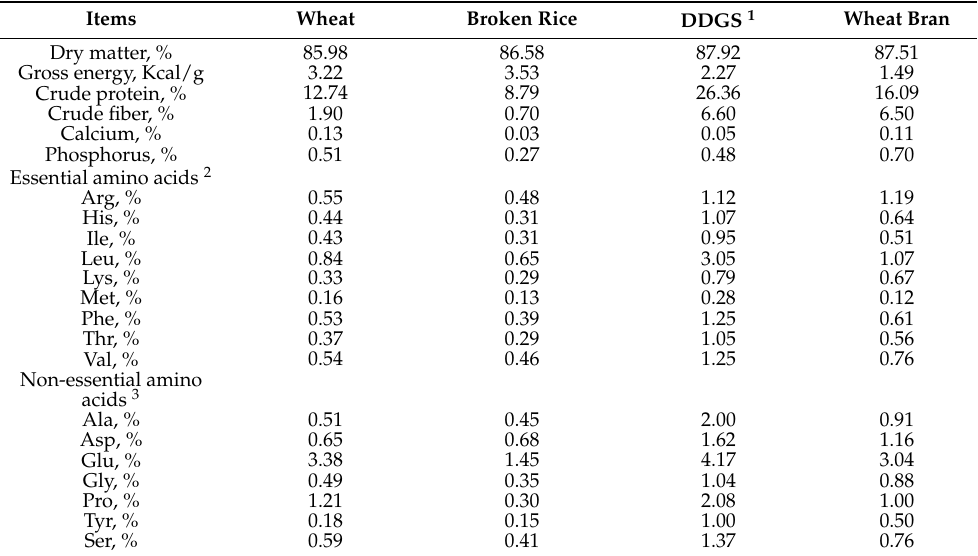
Table 2. Chemical composition (value analyzed) of the experimental ingredients evaluated in the experiments.